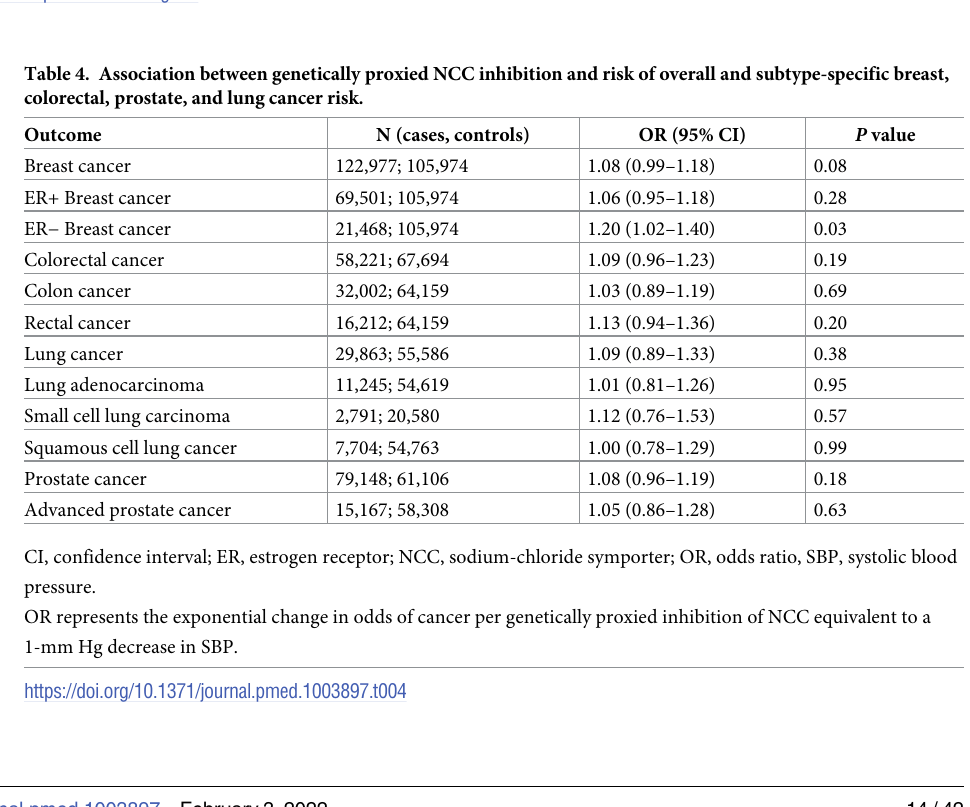
Fig 4. Regional Manhattan plot of associations of SNPs with small cell lung carcinoma risk ± 300kb from the SNP used to proxy SBP (rs1801253) in the ADRB1 region. Mb, Megabase; SBP, systolic blood pressure; SNP, single-nucleotide polymorphism.